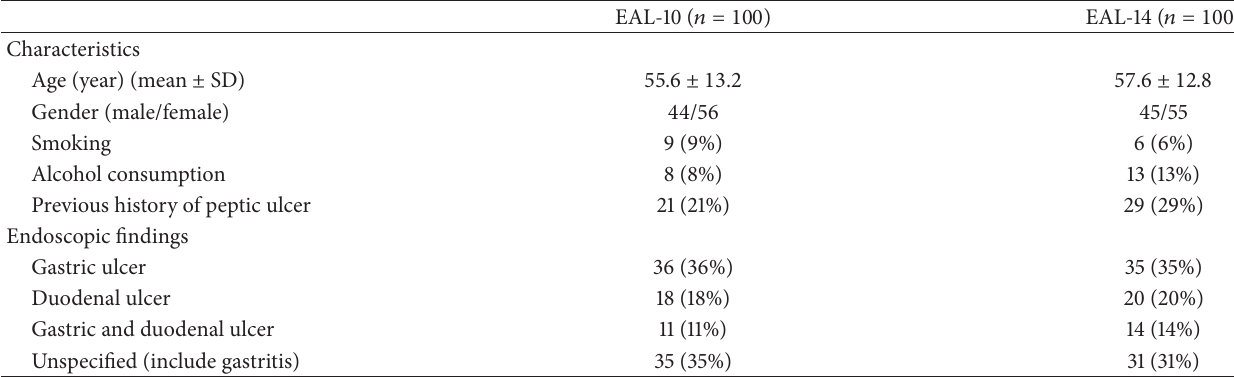
Table 1: Demographic data and endoscopic appearances of the two patient groups.